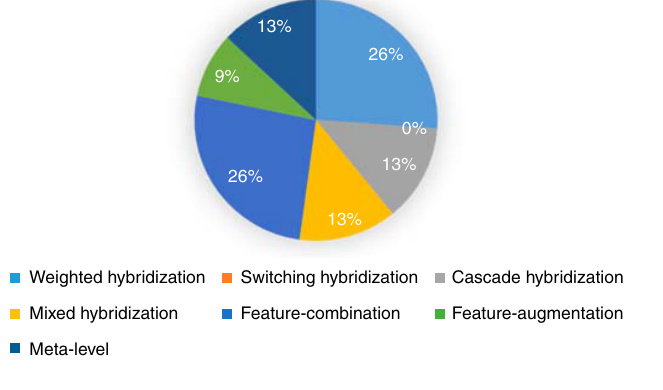
Figure 8. The distribution of the